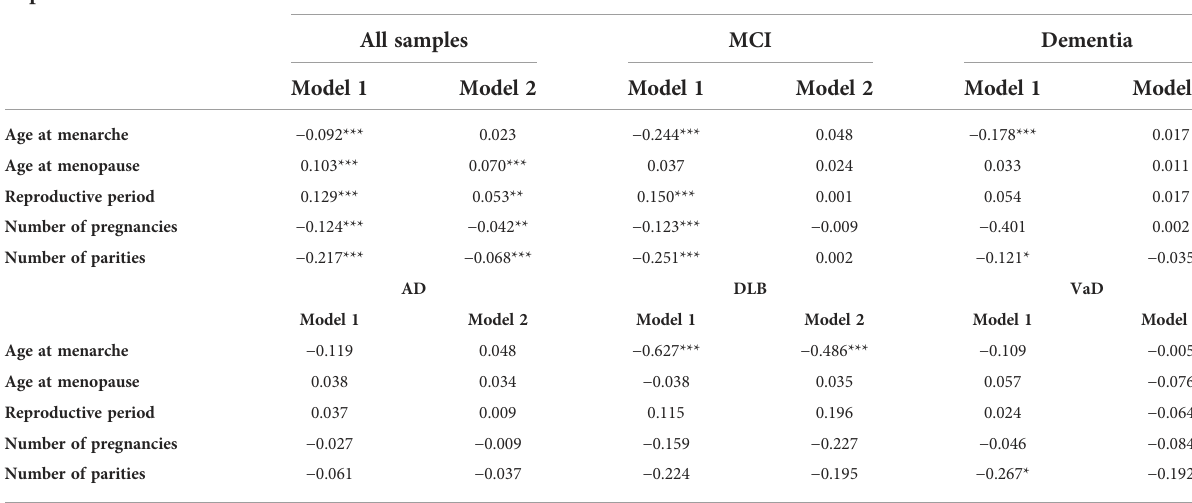
TABLE 3 Correlation coef fi cients of reproductive factors and MMSE score (Spearman ’ s rho). Reproductive